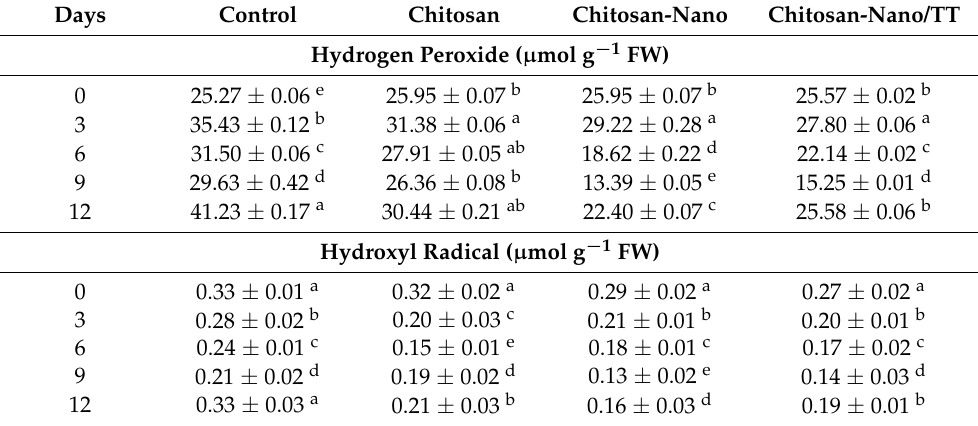
Table 2. Effect of the different coatings on hydrogen peroxide and hydroxyl radical levels in mush- rooms during